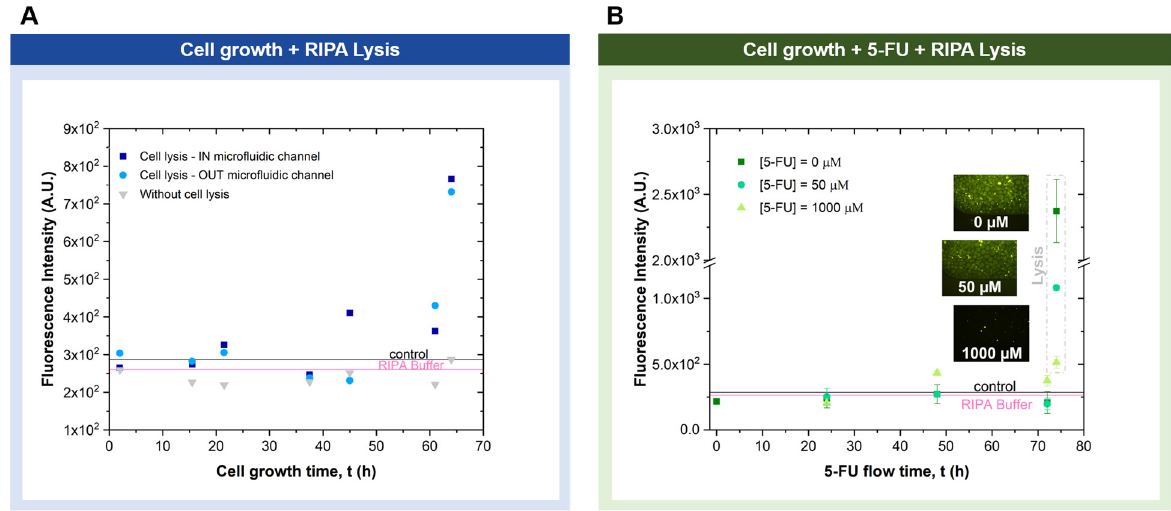
Figure 7. Detection of AK resulting from cell damage in cell chips. Two different procedures were performed: ( A ) cell growth for 61 h with complete cell culture growth medium perfusion followed by lysis inside or outside the microfluidic channel, performed with RIPA buffer. Intermediate measurements of AK before lysis were taken during this period (n = 1); ( B ) cell growth for 24 h with complete cell culture growth media perfusion, followed by the continuous 5-FU injection at different concentrations during 72 h. Intermediate measurements of AK were taken during this period. At the end of this period, lysis was performed by flowing RIPA buffer inside the microfluidic channel (n = 2). In both cases, the control and RIPA buffer refer to the non-specific background fluorescence value when only the complete cell culture growth medium or RIPA buffer flowed through the channel (in the absence of cells) (n = 3). The excitation wavelength was 450–490 nm